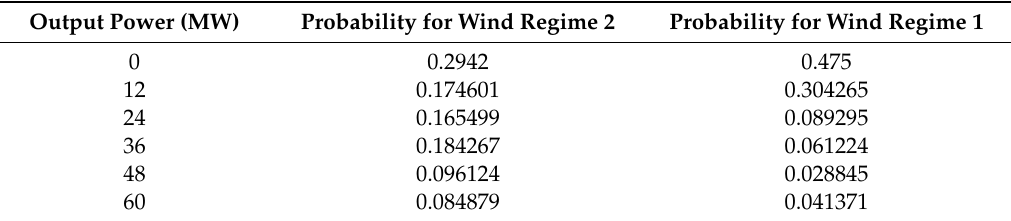
Table 9. Sixty-megawatt wind farm output power model for two types of wind